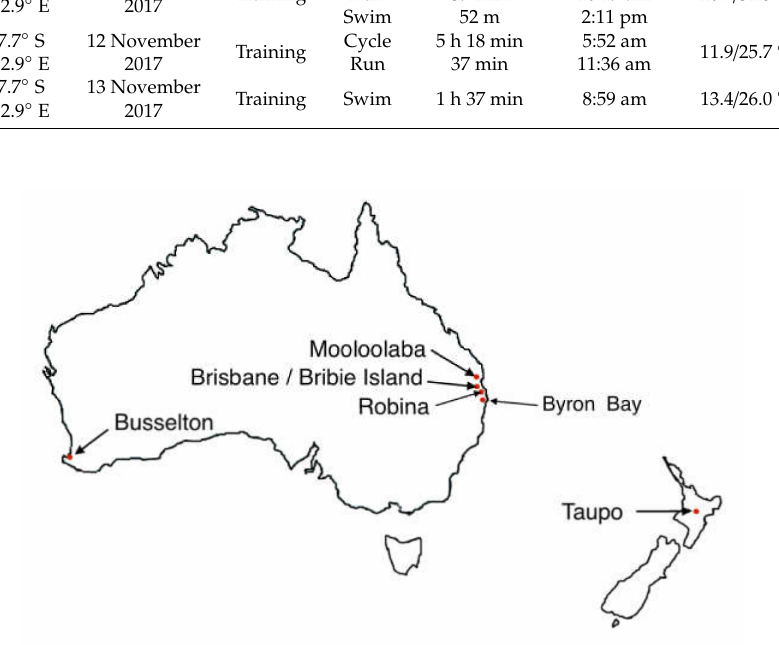
Figure 1. Triathlon event locations. Springfield and Raby Bay are suburbs of the greater Brisbane area. North is at top and scale is approximately 35 × 50 ◦ .